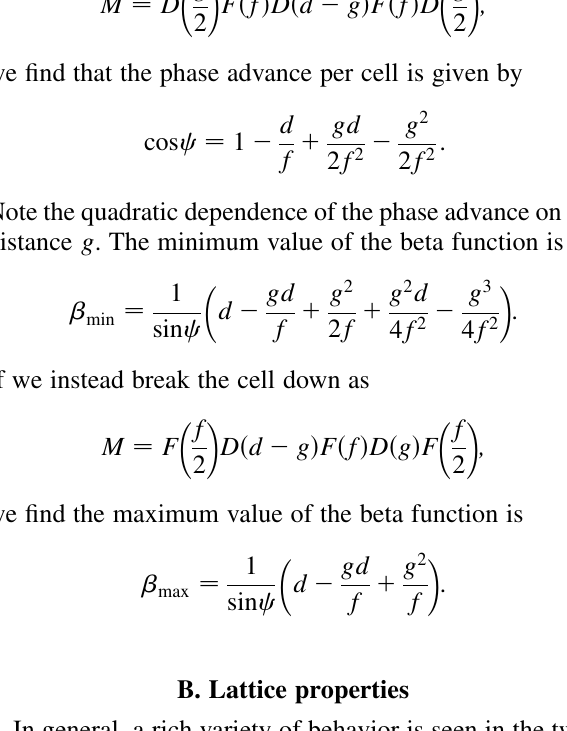
FIG. 14. (Color) Width of the second passband, and beta func- tion at the cell boundary and cell midplane as a function of g for the h(cid:8) (cid:8) j (cid:1) (cid:1)i symmetry class. The other parameter values were d (cid:2) 275 cm , L (cid:2) 50 cm , a (cid:2) 35 cm , and t (cid:2) 11 cm